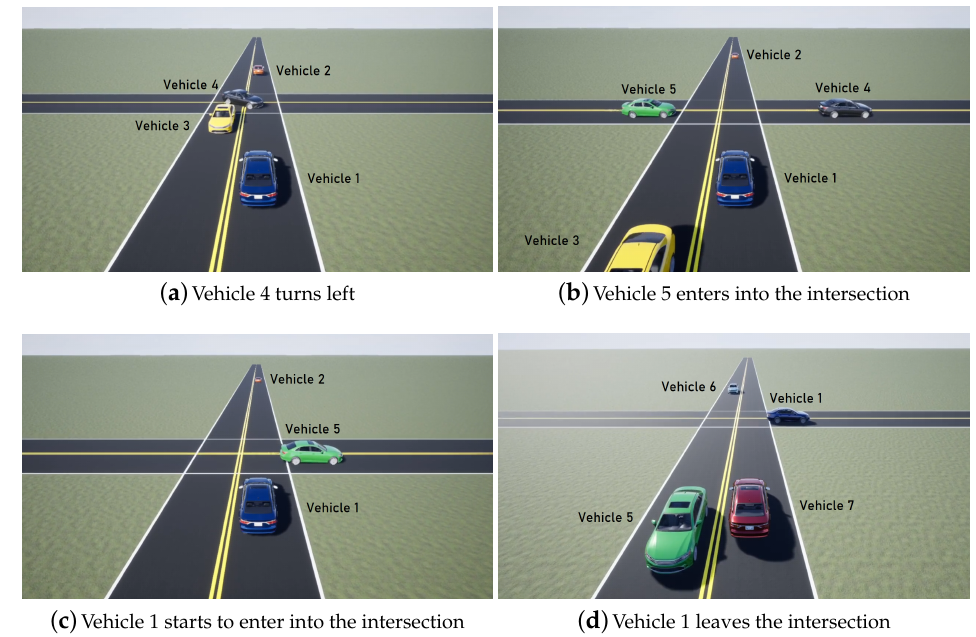
Figure 10. Illustration of the complex fourth